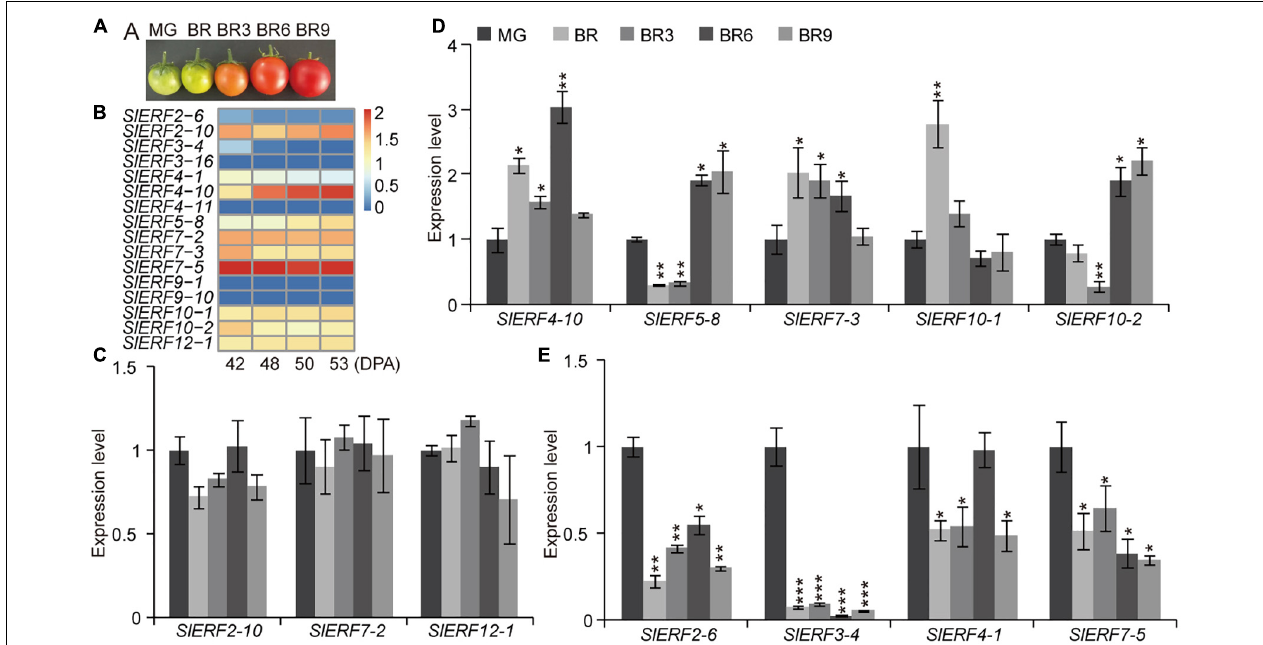
FIGURE 7 | Expression levels of the EAR motif-containing SlERF genes in tomato fruit ripening. (A) Tomato fruit ripening images. (B) Heatmap analysis of the EAR motif-containing SlERF genes based on TPM values in tomato fruit ripening. (C–E) The expression levels of 12 EAR motif-containing SlERF genes in tomato fruit ripening. MG, mature green; BR, the beginning of the breaker stage; BR3, BR6, and BR9, 3, 6, and 9 days after the BR, respectively. Student’s t -test: * p < 0.05, ** p < 0.01, and *** p <